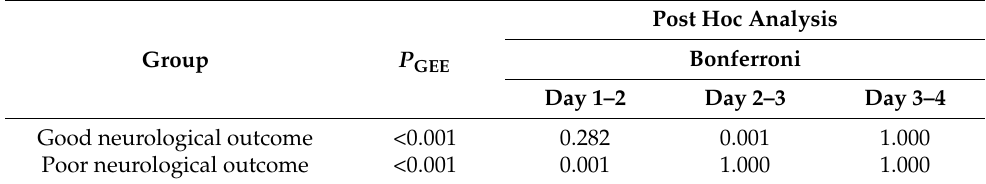
Post Hoc Analysis